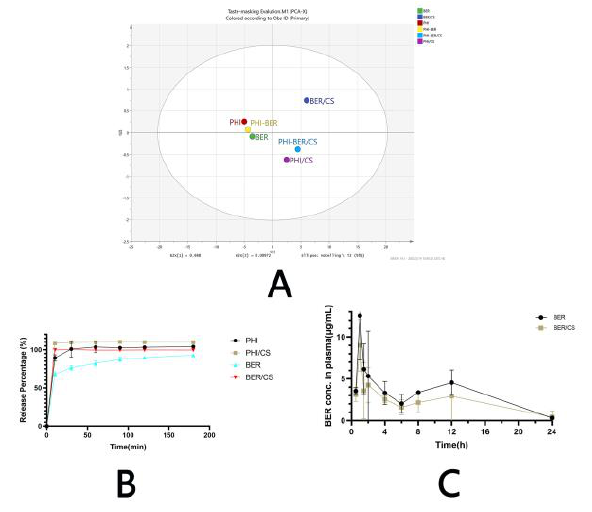
Figure 7. Evaluation of BER/CS, PHI/CS and BER − PHI/CS. ( A ) Electronic tongue test of BER, PHI, BER − PHI, BER/CS, PHI/CS, and BER − PHI/CS. ( B ) Dissolution profiles of BER, BER/CS, PHI and PHI/CS ( n = 3). ( C ) BER and BER/CS blood concentration–time curve ( n = 9).